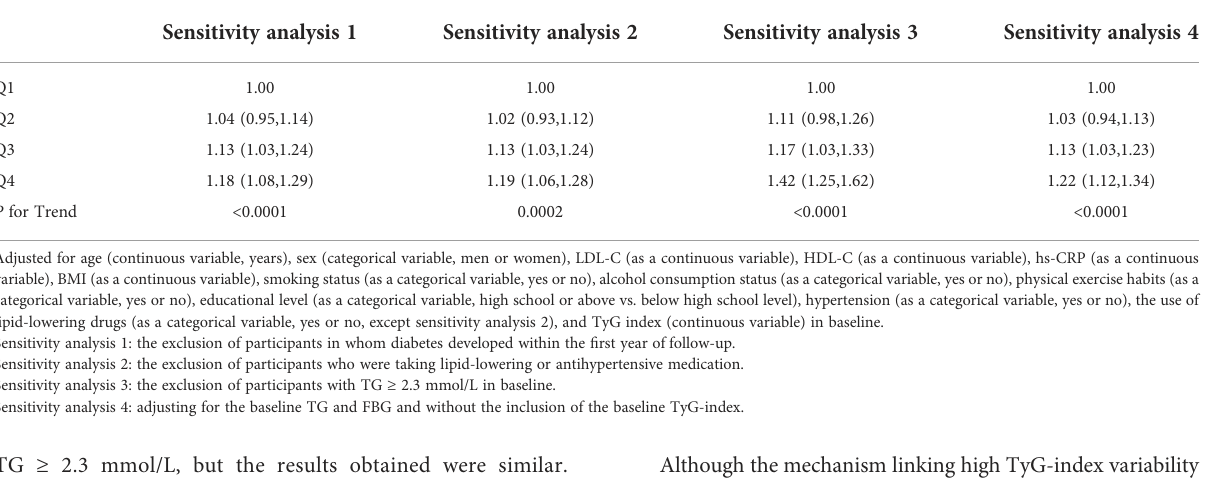
TABLE 5 Sensitivity analysis of the association of TyG index variability with incident diabetes.